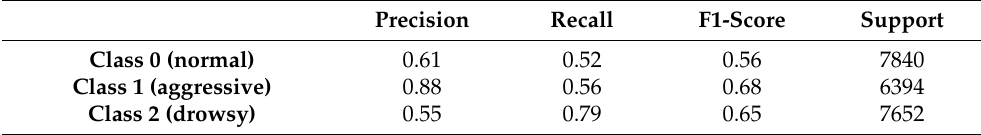
Table 7. Multi-class evaluation metrics with random forest classifier for traffic status. Precision Recall F1-Score